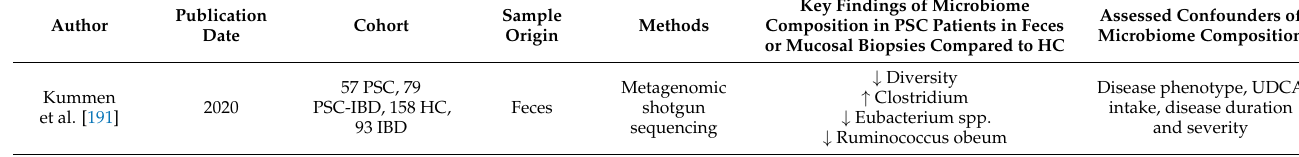
Table 1. Summary of studies investigating the gut microbiome in PSC. Only full papers are listed. Key findings of microbiome composition are influenced by the personal opinion of the authors of this review because it represents a selection of